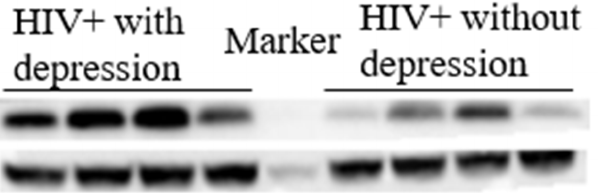
Figure 1. Representative image of protein levels of NUCB1. Western blotting results showed that in HIV-infected individuals, having comorbid depression significantly increased the expression of NUCB1 in the cerebrospinal fluid.